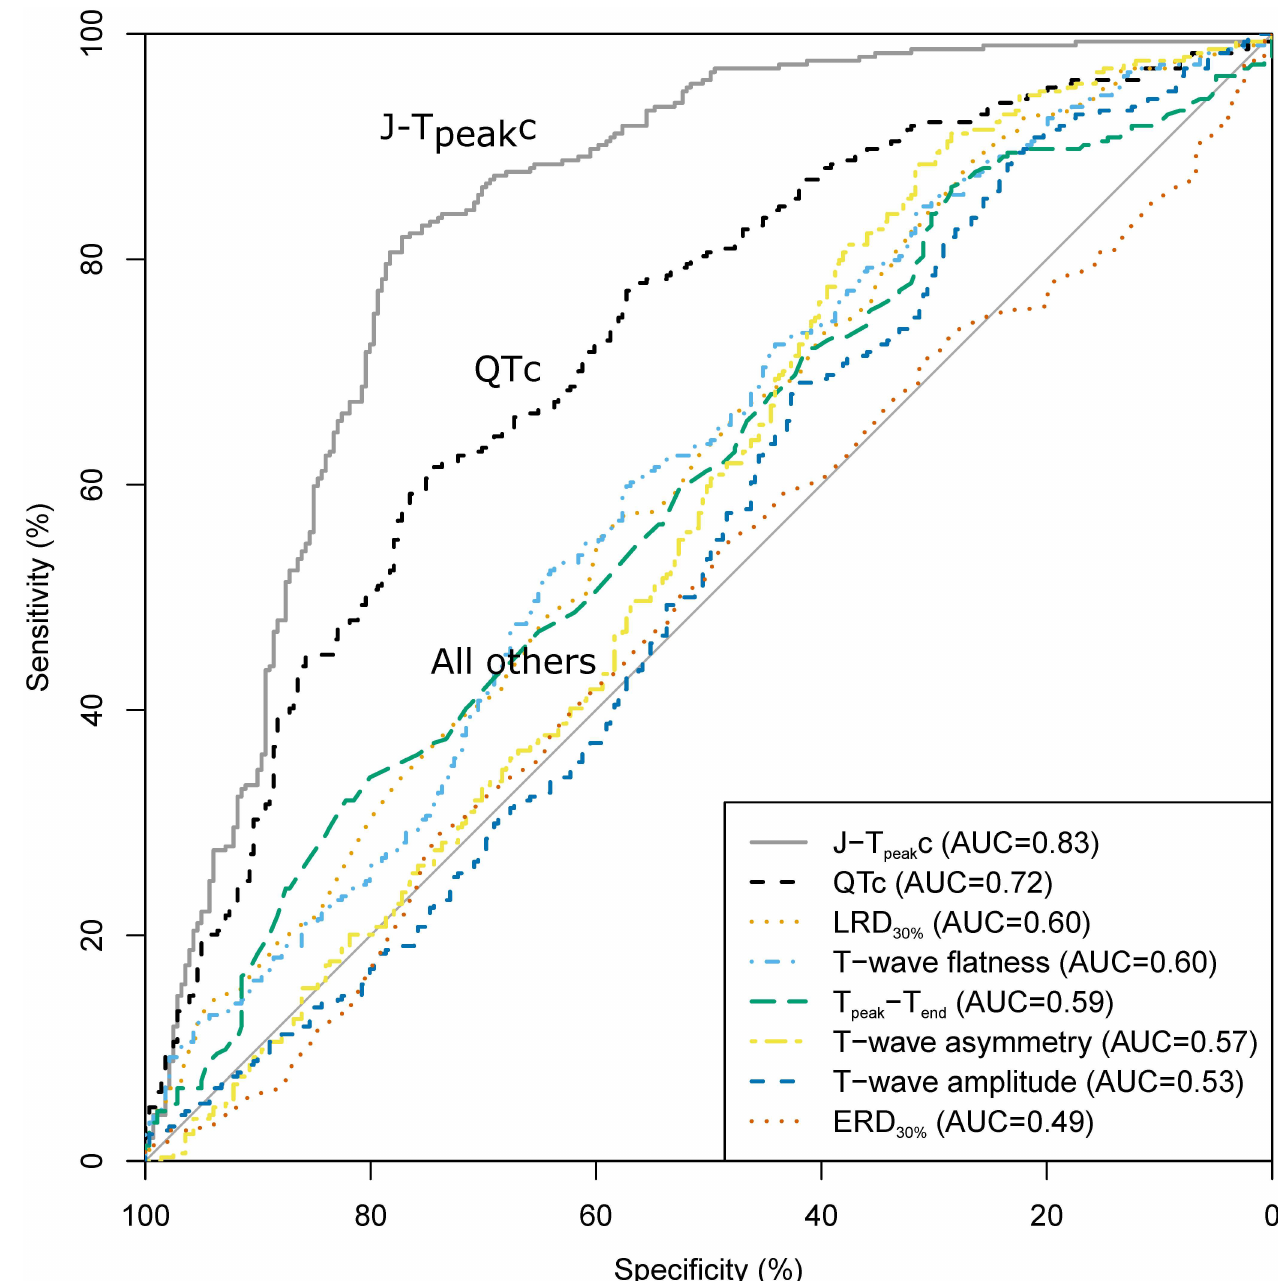
Fig 4. ROC curves for multiple logistic regression models. QTc, Fridericia’sheart rate corrected QT interval; J-T peak c, heart rate corrected J-T peak c interval; T-wave flatness, heart rate corrected T-wave flatness. Area under the curve of each model reported in parenthesis.